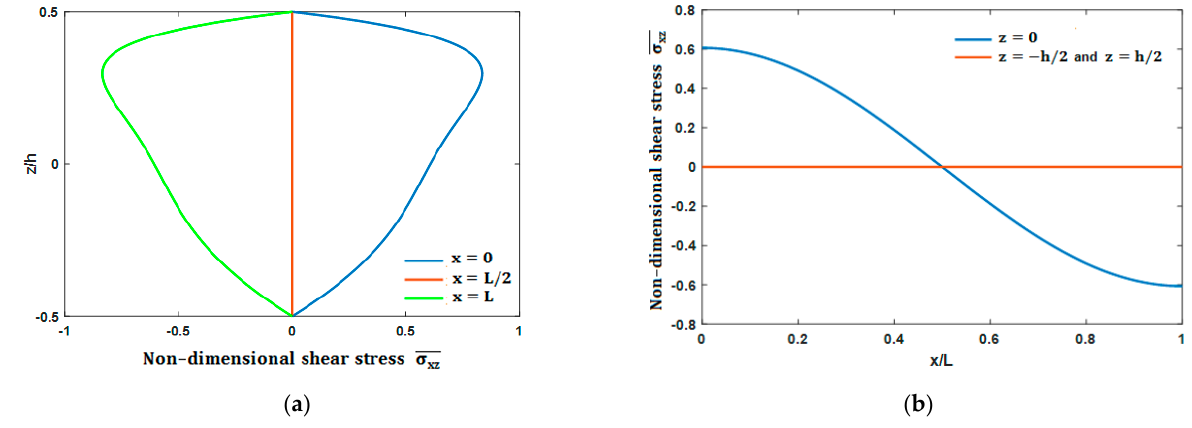
Figure 10. σ xz distributions: ( a ) over the FG beam thickness, ( b ) versus the FG beam non-dimensional length. The thickness-stretching impact on the stresses is evaluated in Figure 11a,b for ( L / h = 5) and ( p = 5). It may be seen that 𝜎 (cid:3053) is equal to zero at both end edges. Its highest value